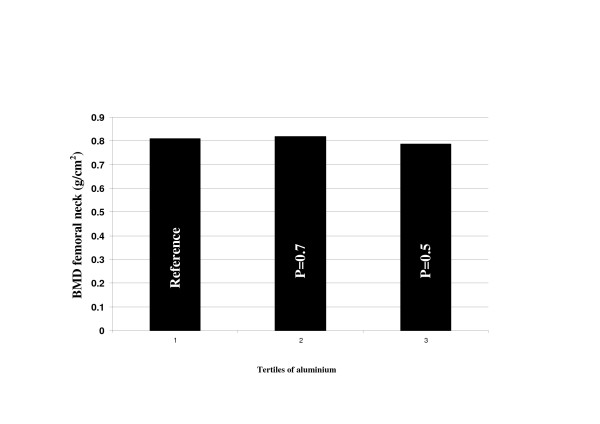
Tertiles Al-BMD. Average adjusted bone-mineral density and content values of the femoral neck by tertiles of aluminium content of bone. Included in the multivariate model were sex, age (by 10-year groups), body-mass index (continuous), height (continuous), creatinine clearance (continuous), demented hip fracture cases (dichotomous) and non-demented hip-fracture cases (dichotomous).